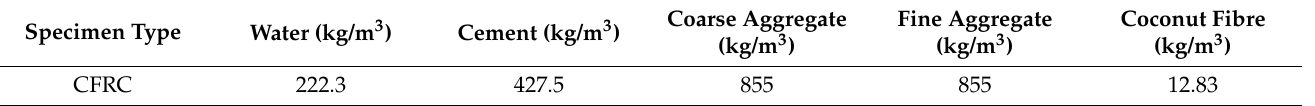
Table 2. Mix design details of the specimens.